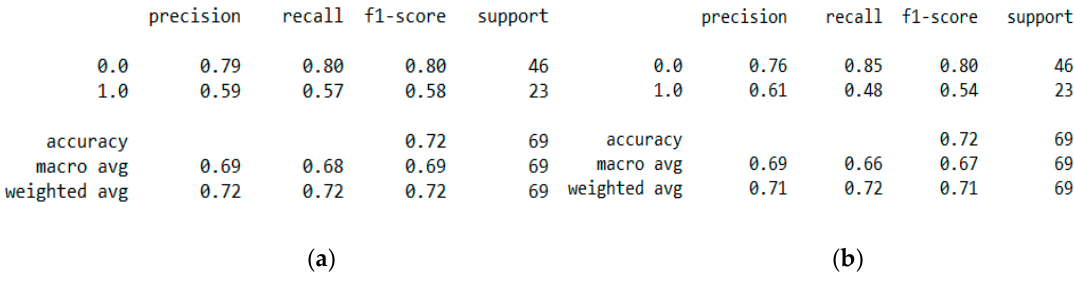
Figure 18. ( a ) Performance metric of the “SVM” classification with a 5-fold cross validation. ( b ) Performance metric of the “Logistic Regression” classification with a 5-fold cross validation.